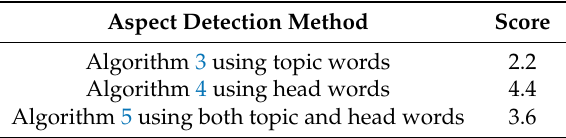
Table 7. Comparison of three proposed methods for automatically generating